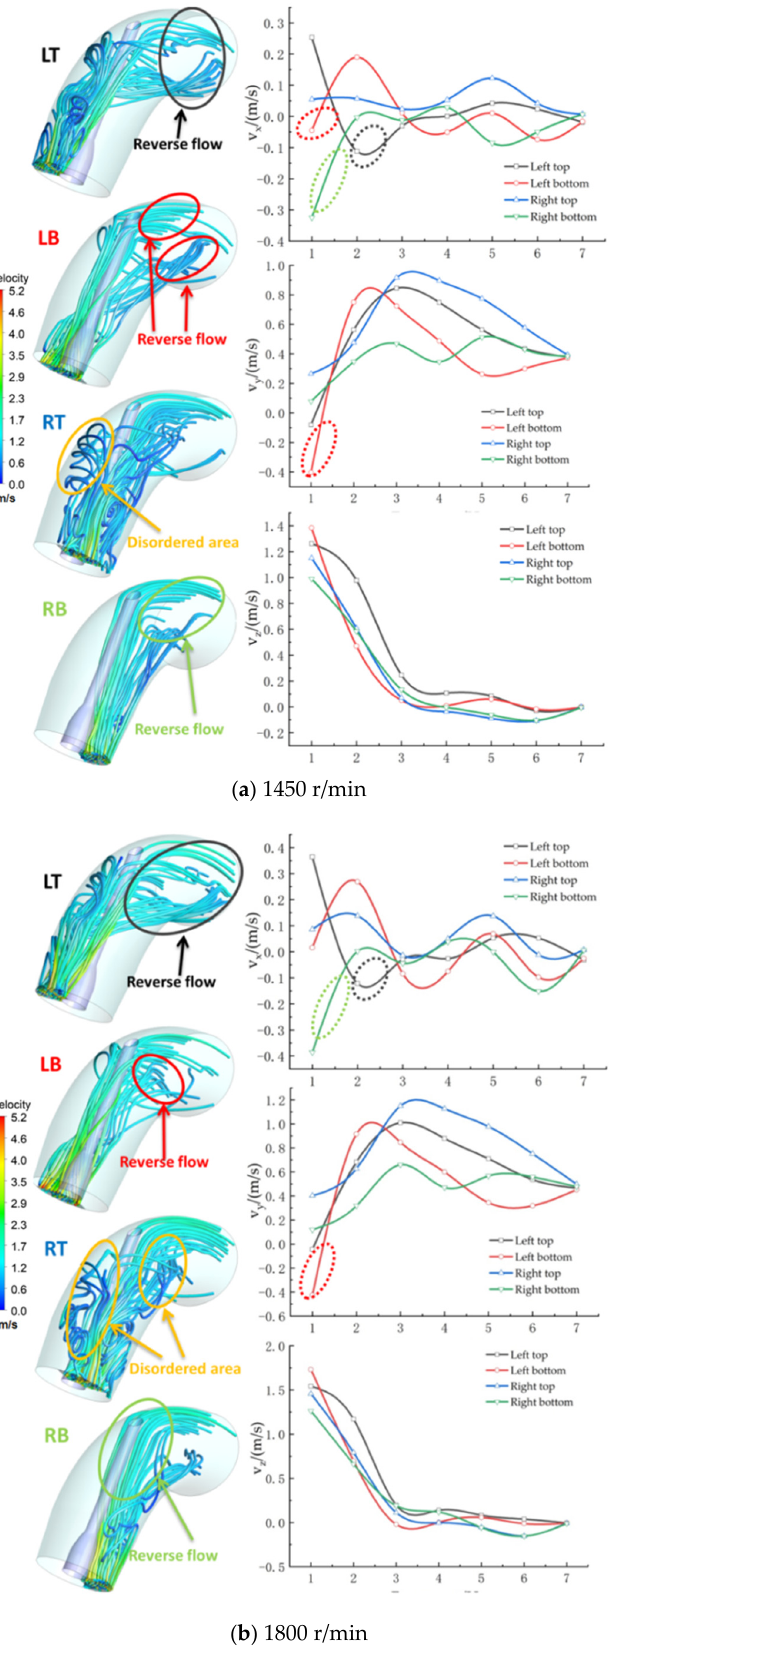
Figure 13. Fluctuation of velocity component distribution along straight outlet conduit.